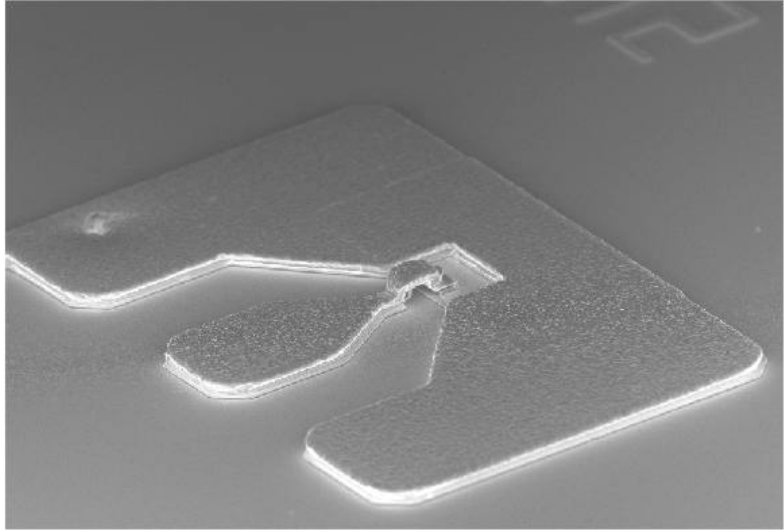
Figure 6. Coplanar layout for S-parameter measurements with air bridge